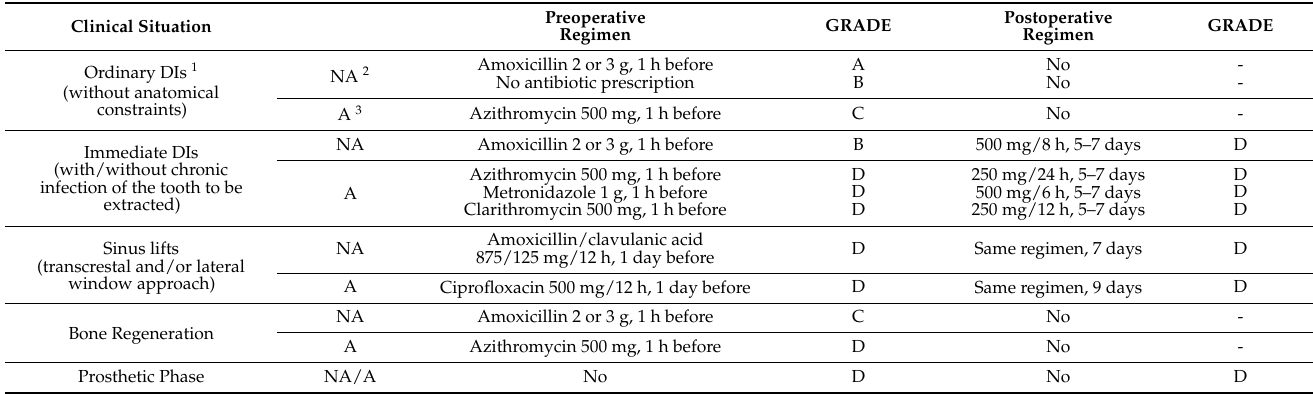
Table 7. Quick reference summary table of